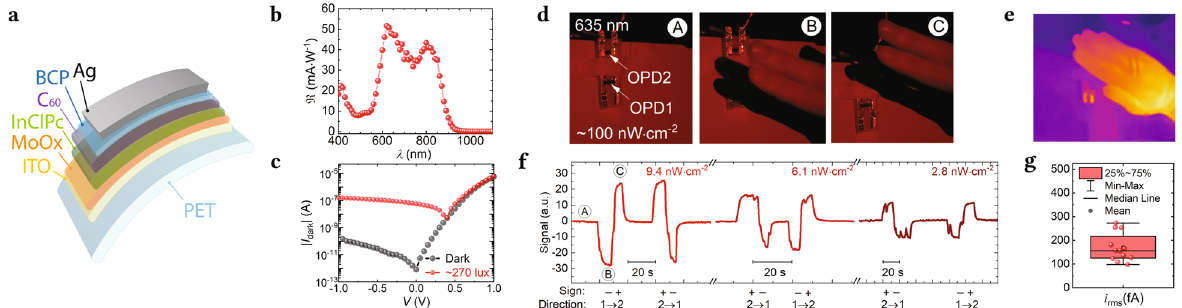
Fig. 2 Device and characteristics. a Schematics of a single organic photodiode (OPD) used in a computational photodetector. b The spectral responsivity of the OPD. c The current-voltage ( I – V ) characteristics of the OPD in the dark and at 270 lux under fl uorescent room lights. d Photographs of a computational photodetector — a pair of OPDs connected in parallel and opposite polarity, under ~100 nW cm − 2 optical power of red LED with 635 nm peak emission and close proximity interactions with each OPD. e A thermal image of the interaction under ~3 nW cm − 2 optical power of the same 635 nm LED; conditions that are too dark for a regular camera sensor to capture. f Distinctive signals from fi nger swiping in down-up and up-down directions are well above the noise fl oor. g Distribution of root-mean-squared noise current values measured during the experiments in f